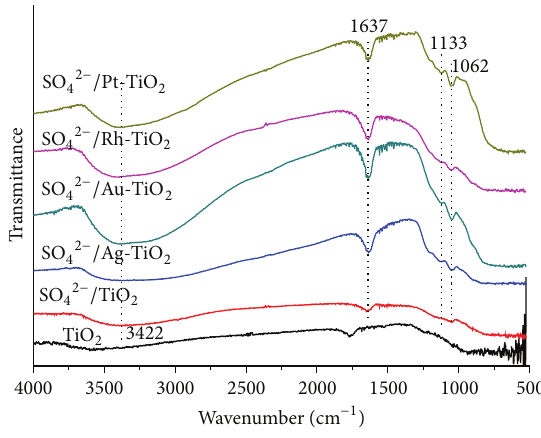
Figure 6: FT - IR spectra of samples.